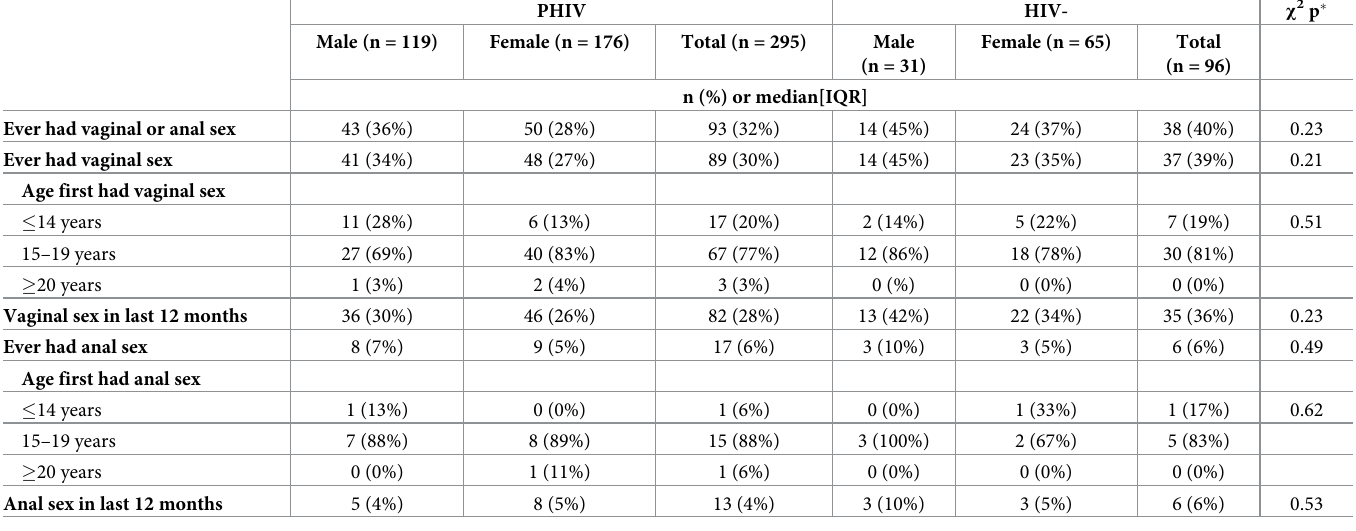
Table 2. Sexual behaviour of PHIV and HIV-